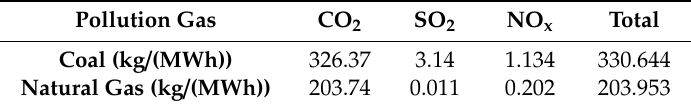
Table 3. Emission coe ffi cients of natural gas and coal